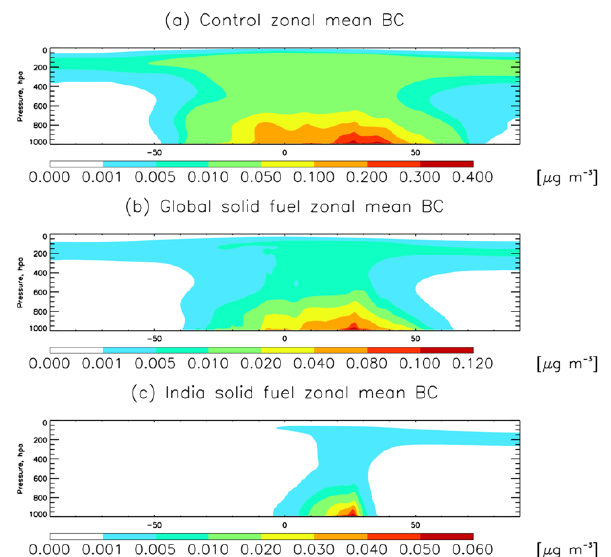
Figure 4. Annual zonal mean BC concentrations from (a) the BASE simulation, (b) the global solid fuel cookstove emissions and (c) In- dia solid fuel cookstove emissions. BC concentrations are calcu- lated under standard temperature and pressure conditions (273K,